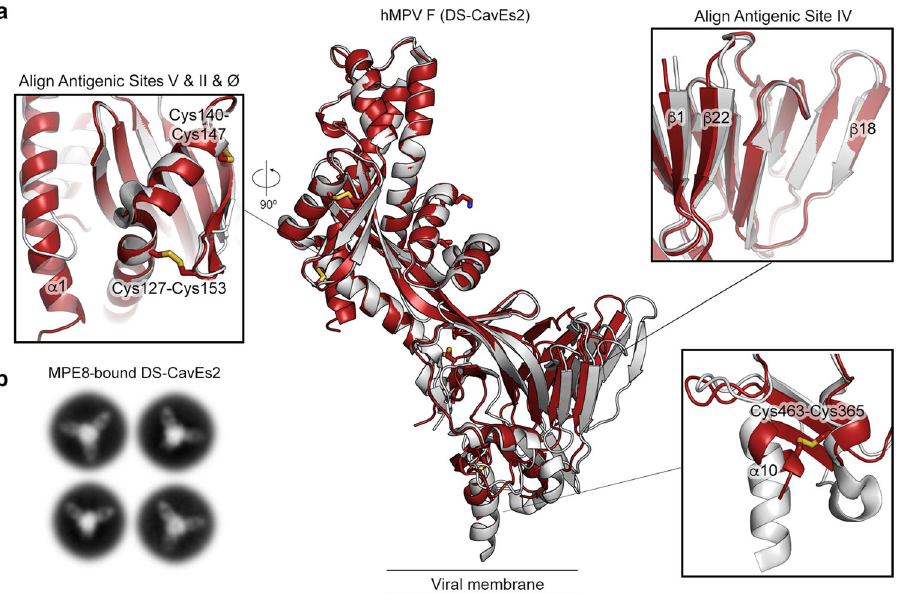
Fig. 5 Crystal structure of hMPV F DS-CavEs2 exhibits a prefusion conformation. a Side view of the atomic model of apo hMPV F variant (DS-CavEs2) in a prefusion conformation. The model (red ribbon) is superimposed with a previously determined hMPV F structure (white ribbon, PDB ID: 5WB0). The side chains of the introduced substitutions are highlighted as sticks. Each inset corresponds to the regions where the superimposition is performed. b Representative negative stain EM 2D class averages of DS-CavEs2 complexed with MPE8